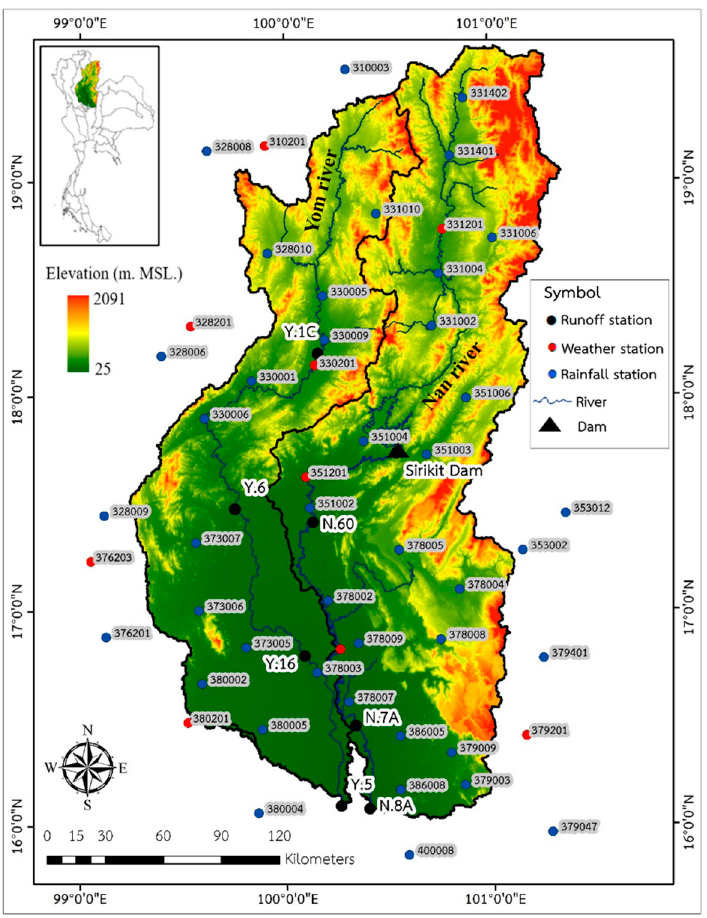
Figure 1. Study area at Yom and Nan River basins, with hydro-meteorological stations and the Sirikit dam.